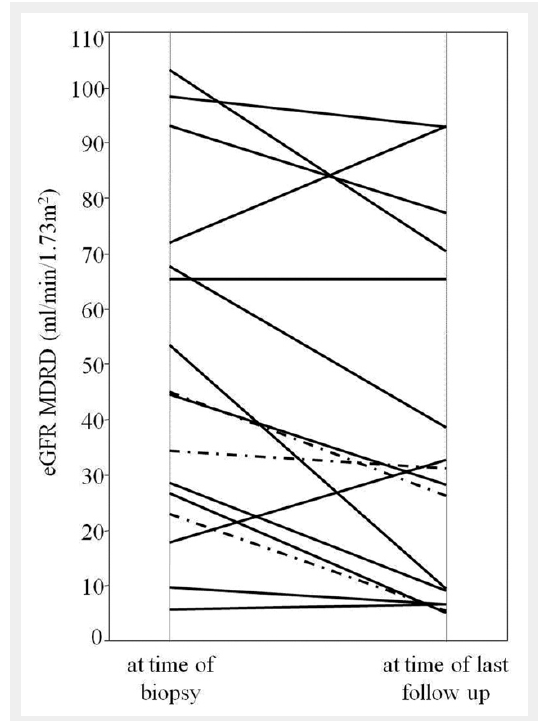
Each solid line shows the course of eGFR of a patient with immunosuppressive treatment, each dashed line shows the course of eGFR of a patient without immunosuppressive